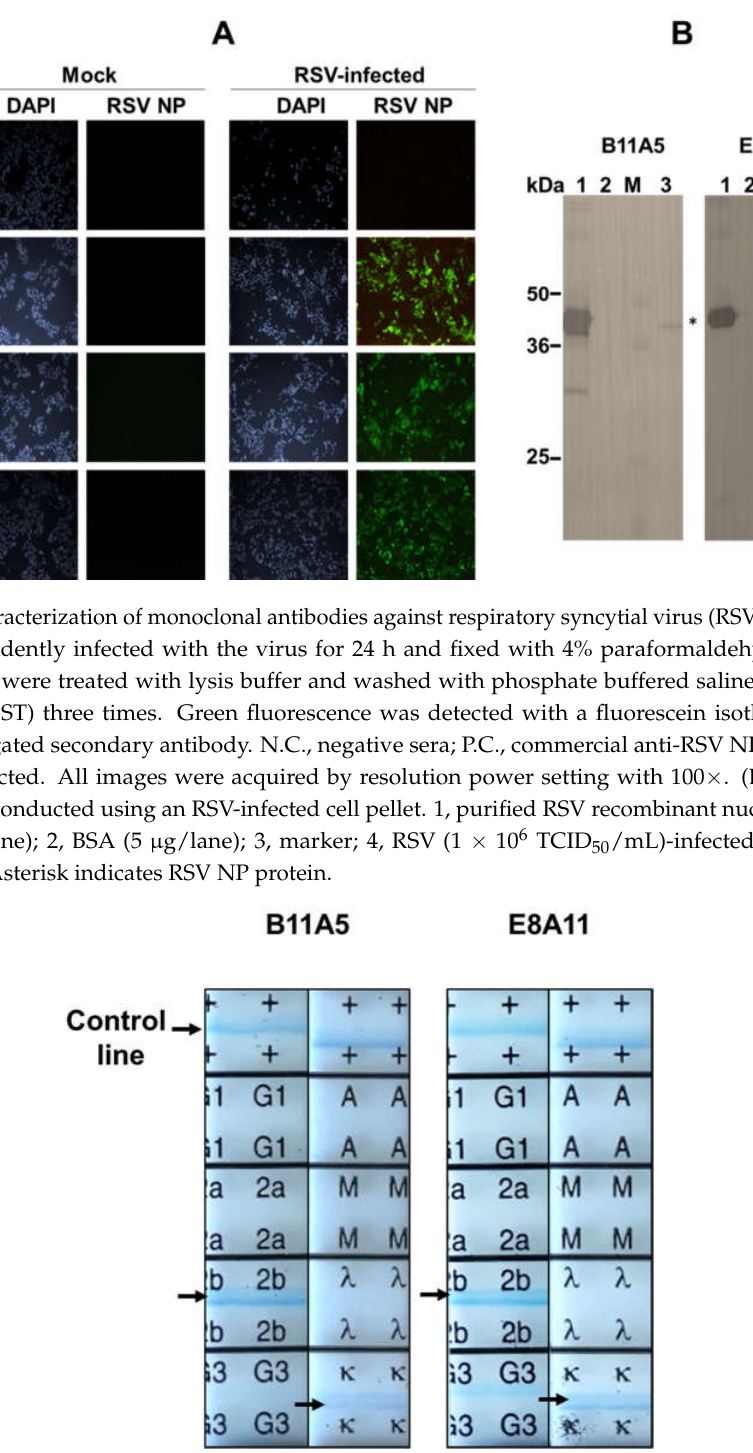
Figure 3. Isotyping of monoclonal antibodies used for the detection of respiratory syncytial virus. IgG subclasses of novel monoclonal antibodies were determined using an Isostrip. Purified antibodies (1 μg/mL) were reacted with the strip for 5 min and read by eye. Black arrows indicate a positive signal.